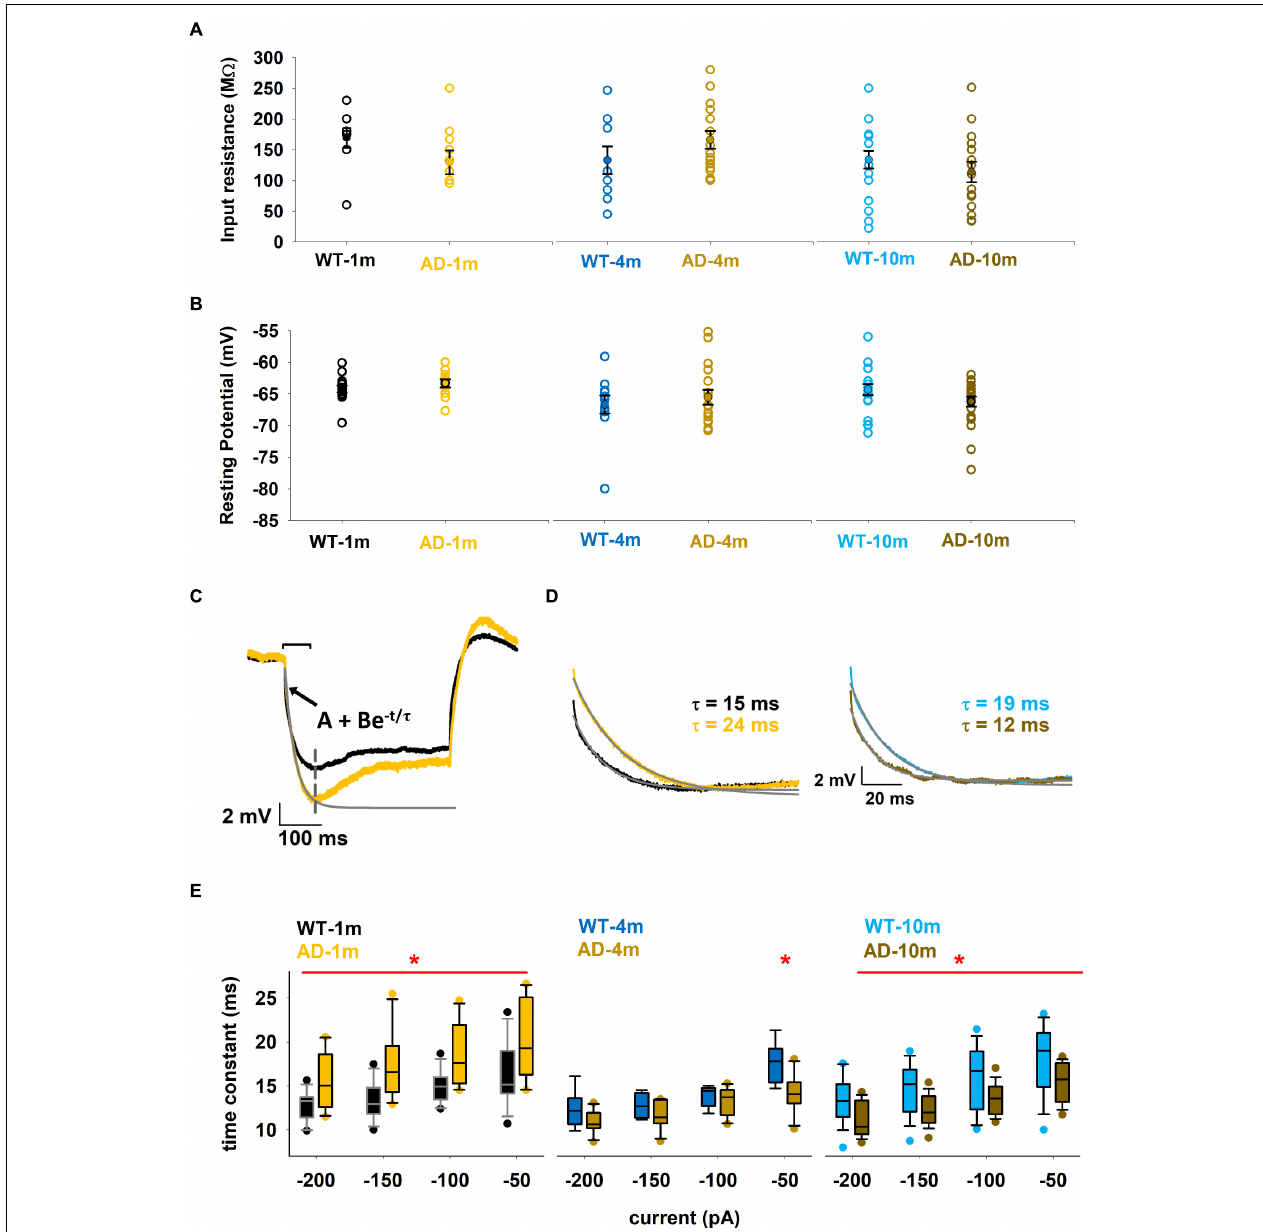
FIGURE 2 | Differences in passive properties. (A) Input resistance of individual neurons for the different conditions. Average values are shown as closed symbols. (B) Native resting potential of individual neurons for the different conditions. Average values are shown as closed symbols. (C) Typical recordings for a –50 pA current injection from a WT-1m (black trace) or AD-1m (orange) mice. The gray line represents the exponential time course best fitting the initial part of the experimental trace and used to calculate τ . The inset shows the equation used for the fit. (D) Typical traces ( left , WT-1m and AD-1m; right WT-10m and AD-10m) used for the calculation of the membrane time constant for a –50 pA input current. Gray lines represent the exponential decay used to calculate τ values; experimental traces have been rescaled to have the same minimum value. (E) Box plot of membrane time constant as a function of the current injection. The red line and the * symbol indicate for which current the values for WT and AD groups were significantly different ( p ≤ 0.05). See full statistical analysis for all parameters in Supplementary Table 2 .